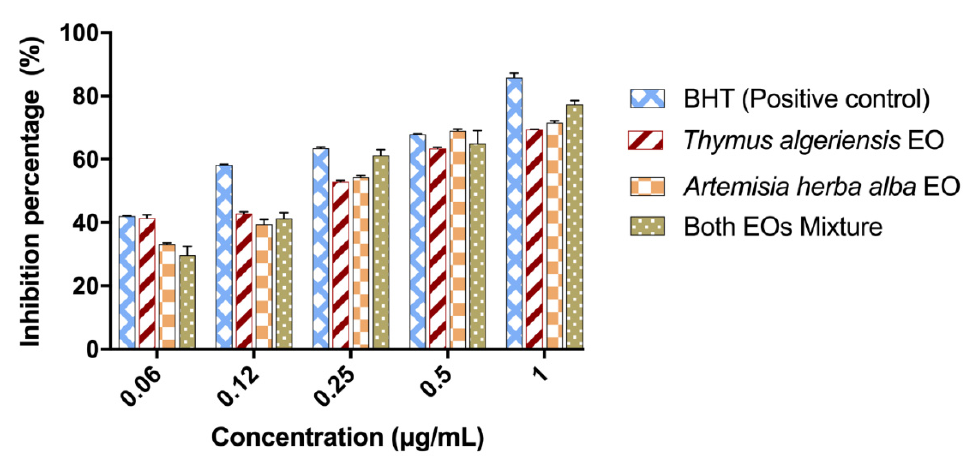
Figure 2. Histogram of the variation in the percentage inhibition as a function of different concentrations in the FRAP assay. The values are expressed as the mean ± standard error of the mean, p < 0.05 is considered significant, compared to the control ( n = 3).